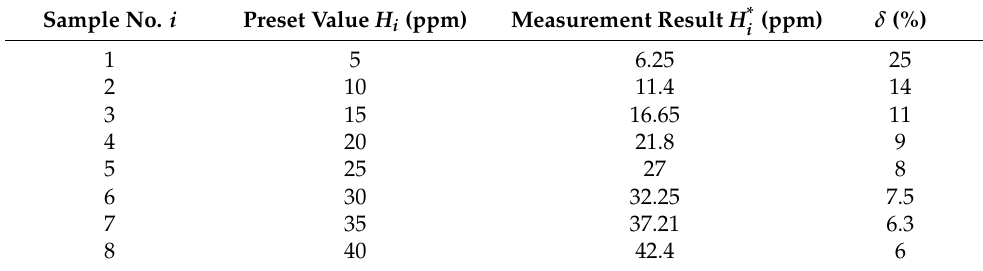
Table 1. Experimental study results. Sample No.